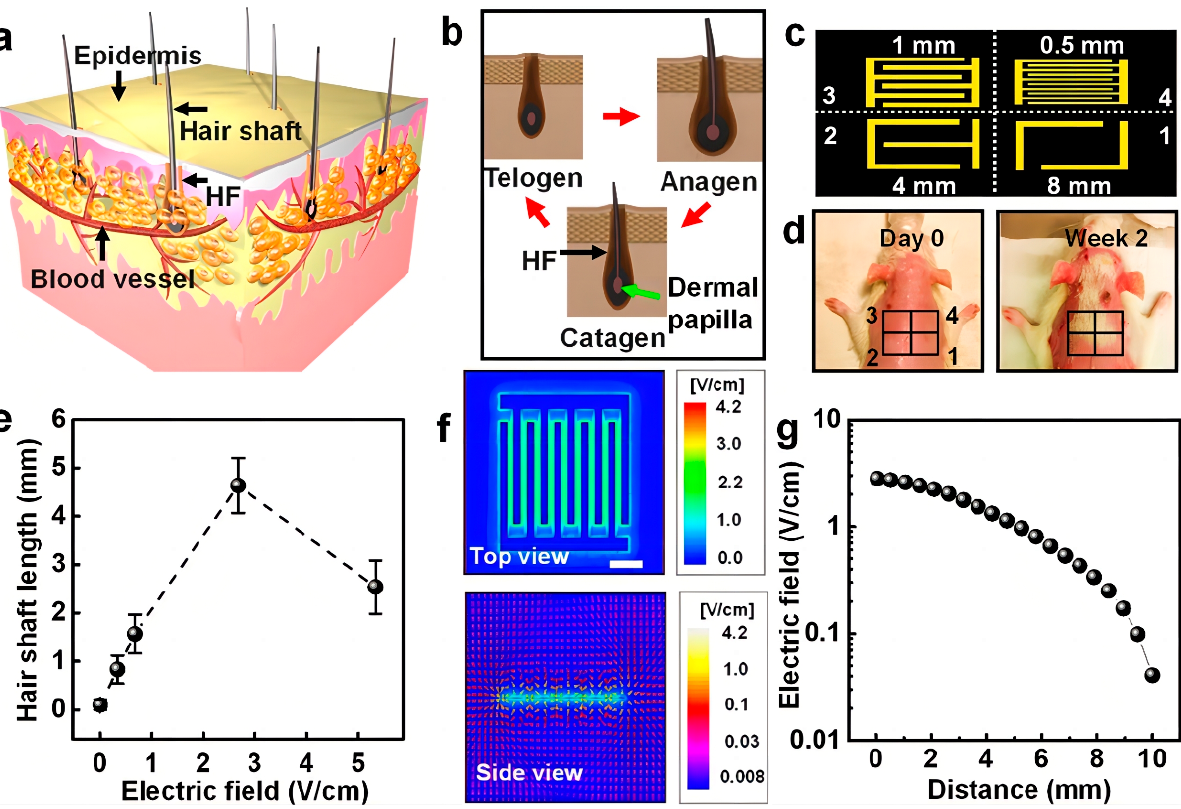
Figure 4. Hair regeneration effect in SD rats under stimulation with the m-ESD. ( a ) Schematic illustration of HFs in the skin. ( b ) Histomorphology of the hair cycle, including anagen, catagen, and telogen phases. ( c ) Schematic diagram of a series of interdigitated electrodes (1–4) with different gap widths. ( d ) Photographs of rats with removed hair (day 0, left ) and after 2-week treatment ( right ). ( e ) EF-stimulated hair shaft length as a function of the EF intensity (n = 6). ( f ) Top and side views of EF distribution (gap width = 1 mm) after stimulation with a voltage of ± 150 mV. ( g ) EF strength at different distances perpendicular to the plane of the interdigitated electrode (gap = 1 mm). All data in ( e ) are presented as mean ± s.d [31]. Copyright 2019 American Chemical Society.